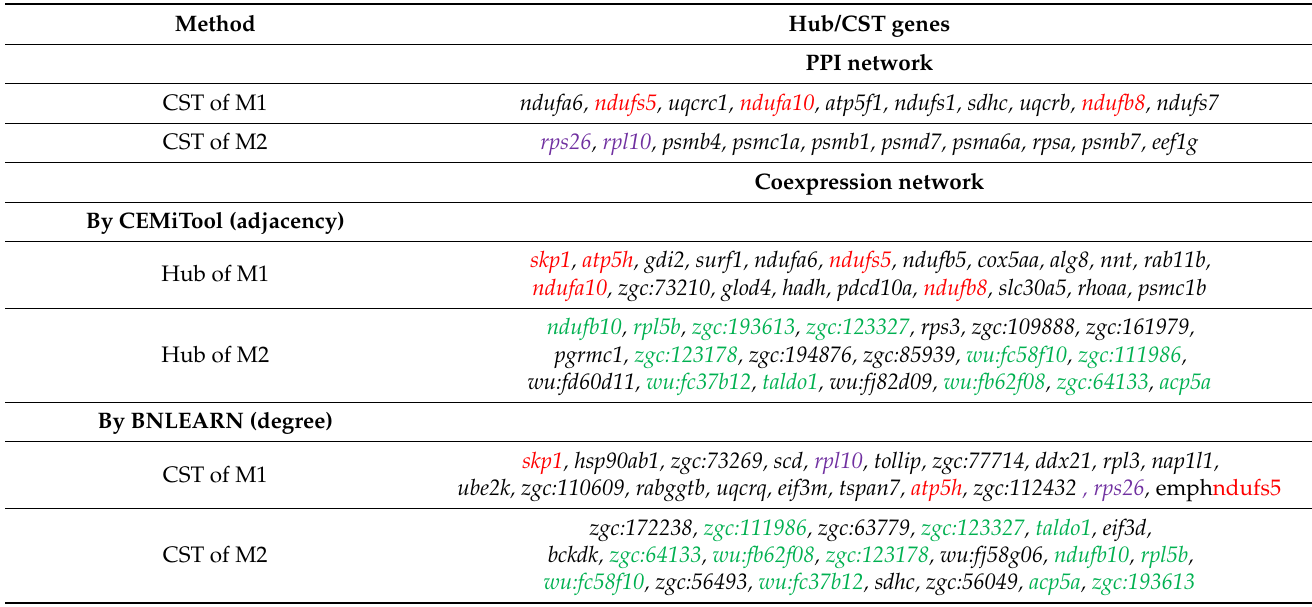
Figure 10. Reconstructed co-expression networks on final meta-analyzed matrix and identified Module 1 (Left) and Module 2 (Right). Table 4. List of hub and CST genes identified by different network reconstruction methods by meta-analysis of GSE11107 and 112272 liver datasets affected by starvation of zebrafish.